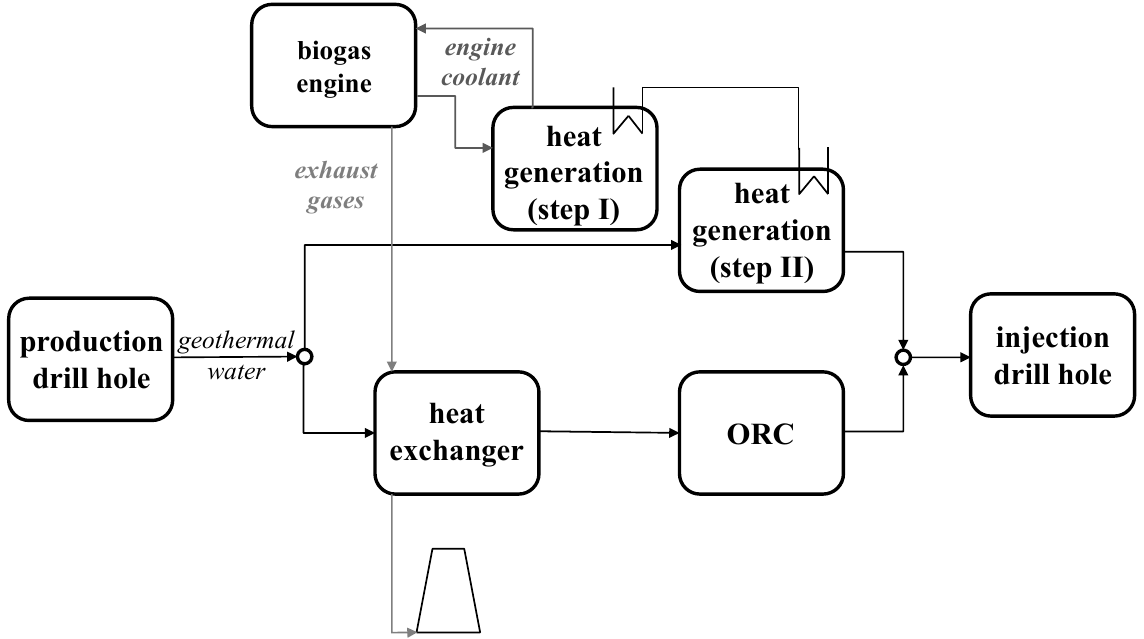
Figure 2. Scheme of geothermal hybrid power plant in parallel